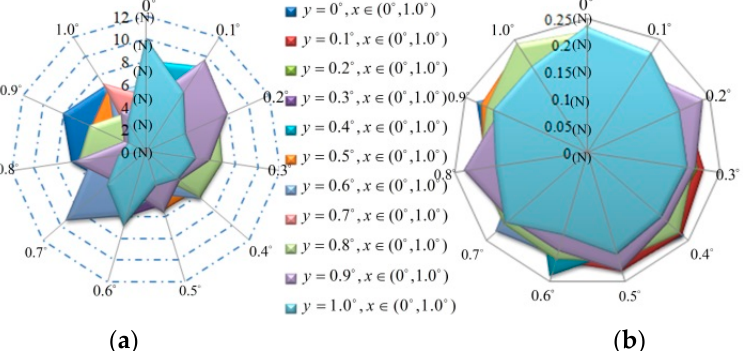
Figure 12. Full stiffness of spherical radial AC HMB (suspension forces versus deflection). ( a ) Experimental value. ( b ) Relative error between calculated value and experimental value.